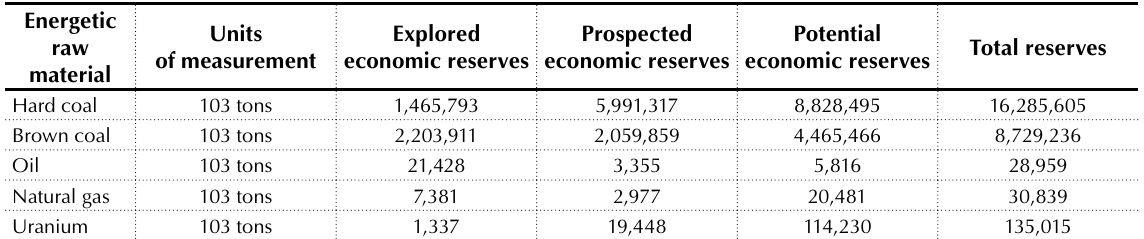
Table 3. Reserves of selected energetic raw materials as of 31.12. 2016